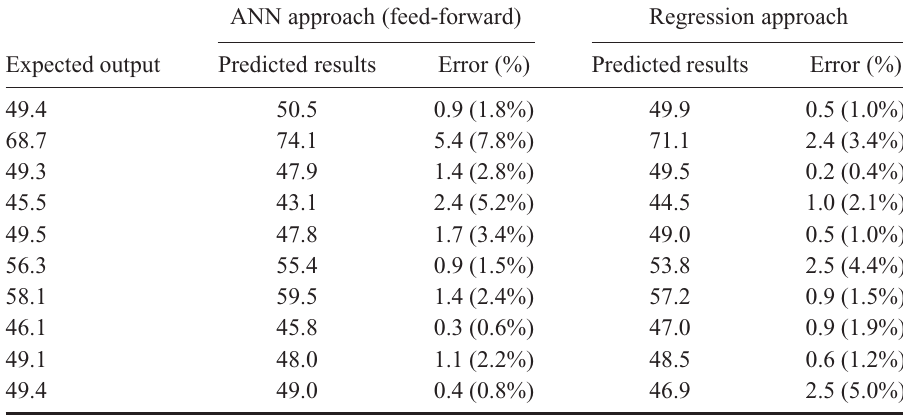
Table 6. Comparison of regression and ANN